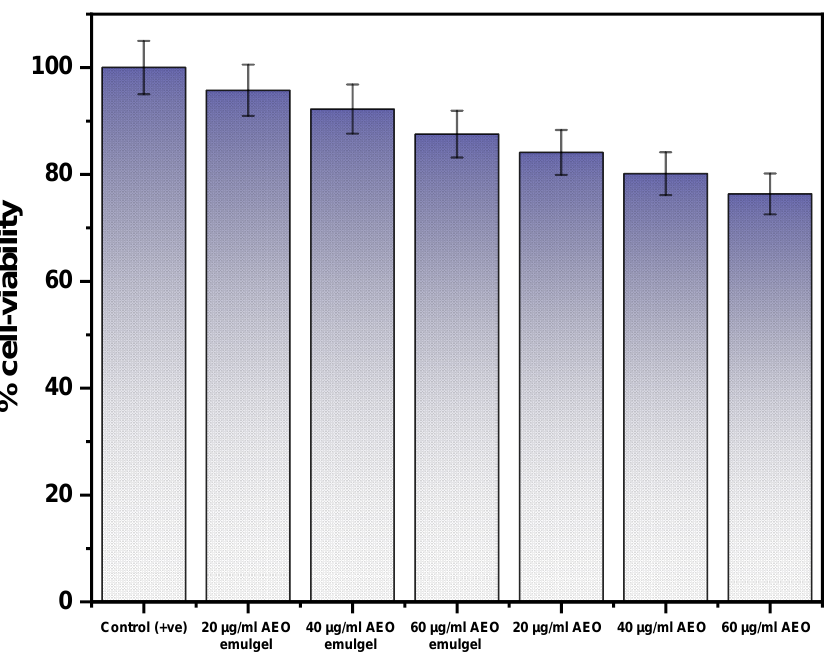
Figure 6. Comparative cell-viability assay for AEOs and AEO emulgel at a concentration ranging from 20 µg/mL – 60 µg/mL in HaCaT.